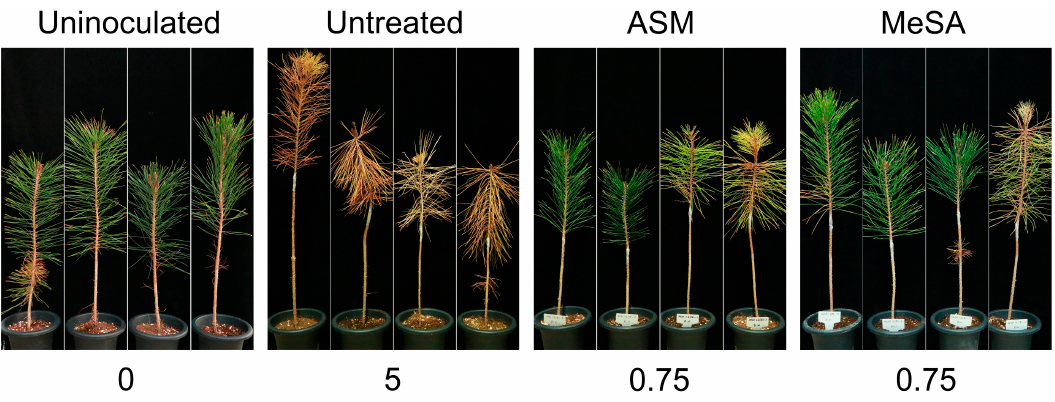
Figure 1. The influence of acibenzolar- S -methyl (ASM) and methyl salicylic acid (MeSA) on pine wilt disease (PWD) resistance. Photographs of pine seedling inoculated with the nematode B. xylophilus were taken at 30 days after resistance-inducing substance treatment. PWD severity was scored for needle discolouration on a scale of 0 to 5. The numbers below the photographs denote the mean severity scores determined from four seedlings per treatment. Uninoculated seedlings served as positive controls, and untreated seedlings, as negative controls.